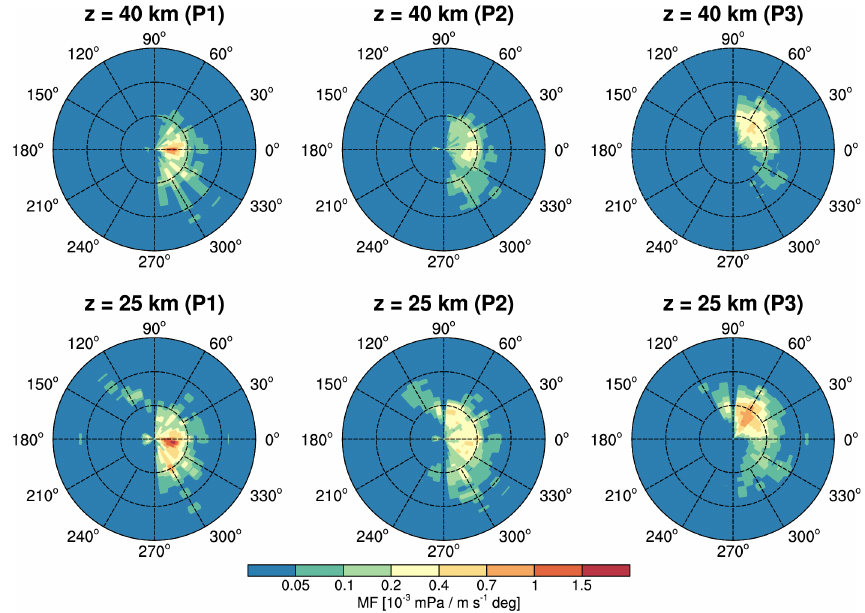
Fig. 3. Momentum flux spectra calculated from model winds for 25km and 40km altitude. Spectra are calculated in terms of k , l and ground based frequency ω gb and binned according to ground based phase speed and propagation direction. The radial coordinate is phase speed, origin is 0ms − 1 , circles give phase speeds of 20ms − 1 , 40ms − 1 and 60ms − 1 . Momentum flux is determined from co-spectra of vertical and horizontal winds. Note the quasi-logarithmic color